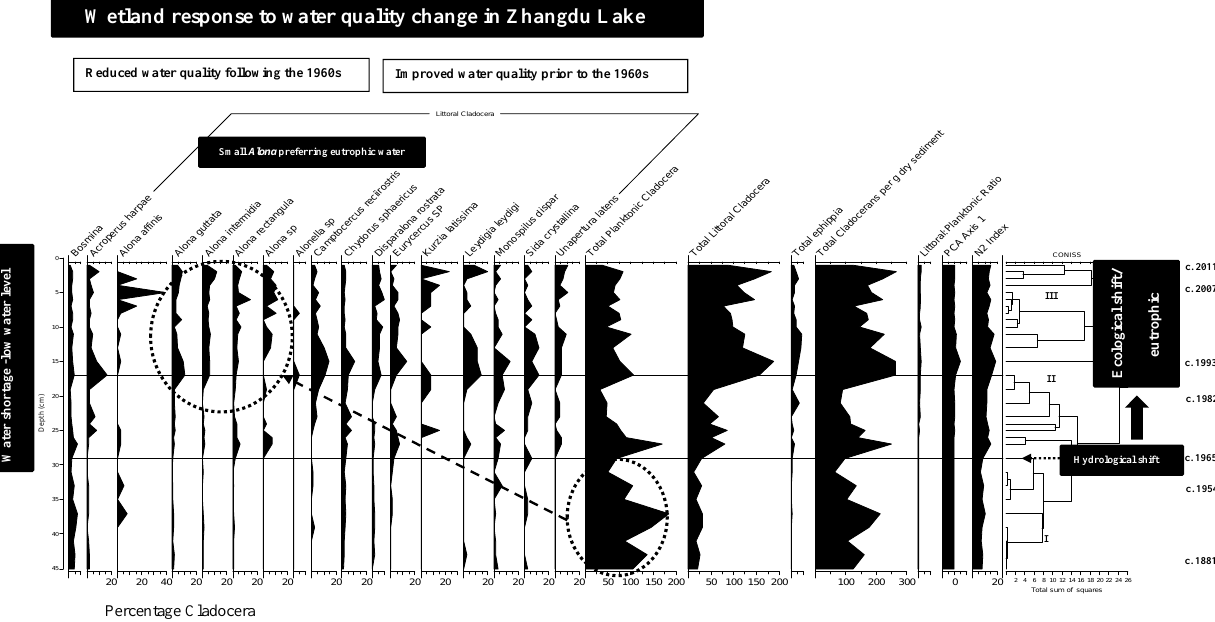
Figure 4. Composition (%) and N2 index of subfossil cladocerans in Zhangdu Lake, and their response to past hydrological and water quality